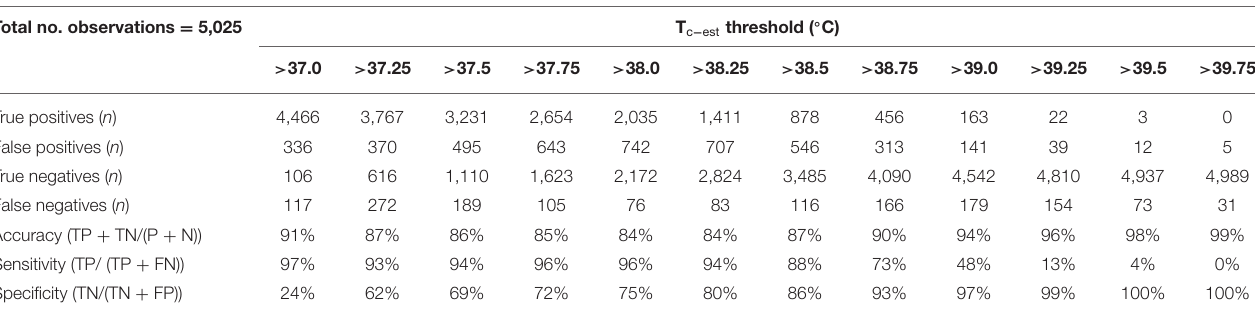
TABLE 2 | Classification of T c − est to predict core temperature value using T c − est thresholds from 37.0 to 39.75 ◦ C. Total no. observations =